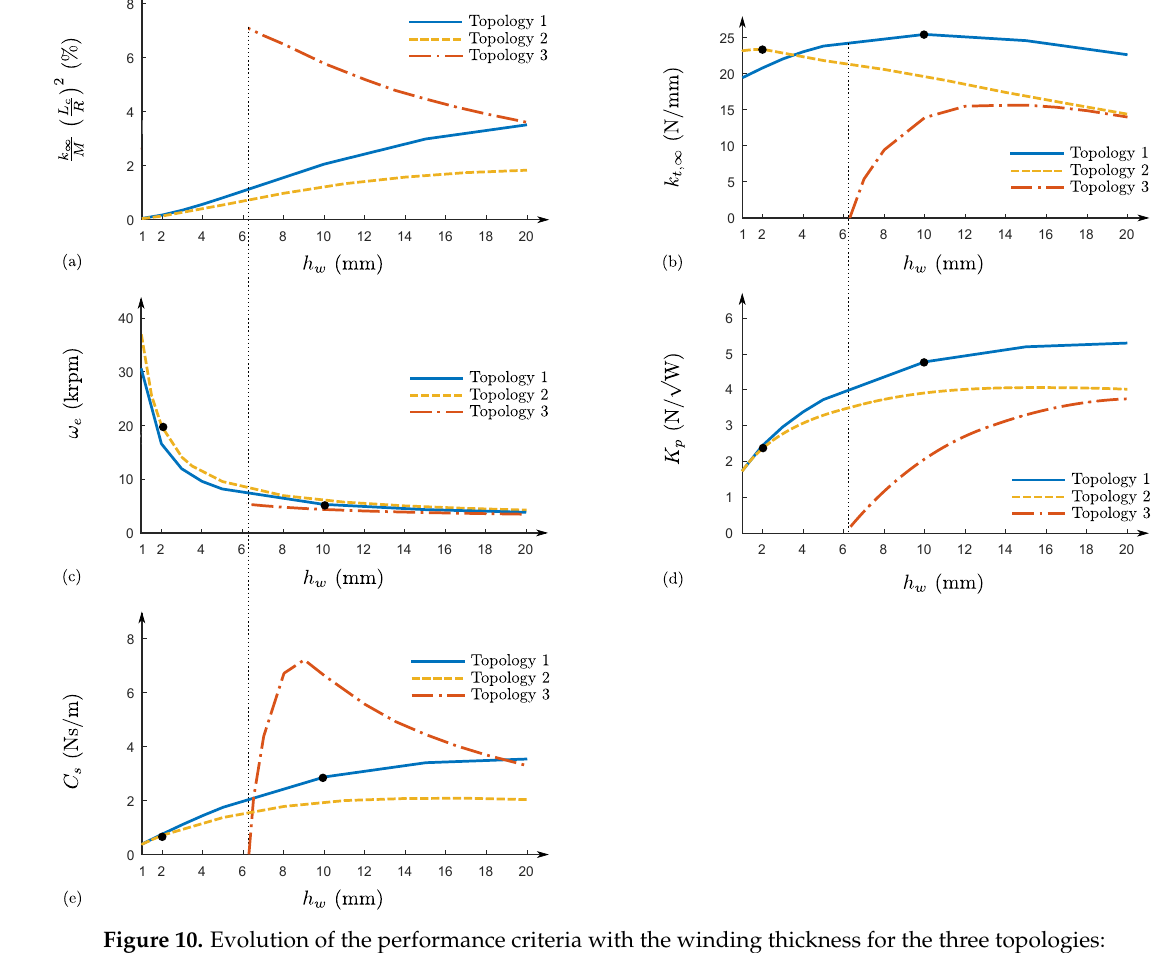
Figure 10. Evolution of the performance criteria with the winding thickness for the three topologies: ( a ) hypothesis validation; ( b ) maximal total stiffness; ( c ) spin speed related to the electrical pole; ( d ) energy efficiency coefficient; and ( e ) stability